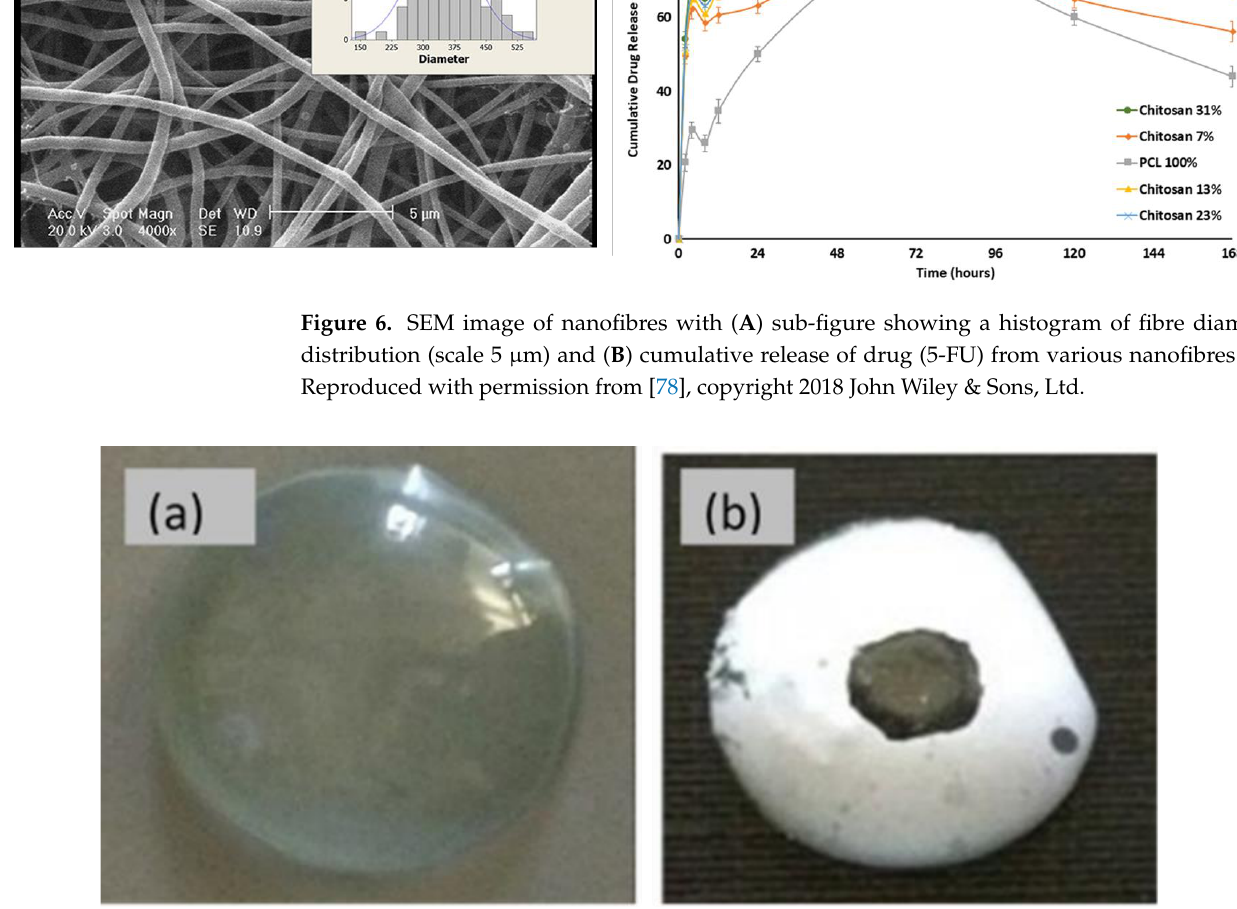
Figure 7. Digital images of uncoated ( a ) and ( b ) coated lens. Reproduced with permission from [82], copyright 2017 Elsevier. Table 2. Summarised characteristics of some studies employing monoaxial electrospinning for drug delivery applications. Polymer(s)